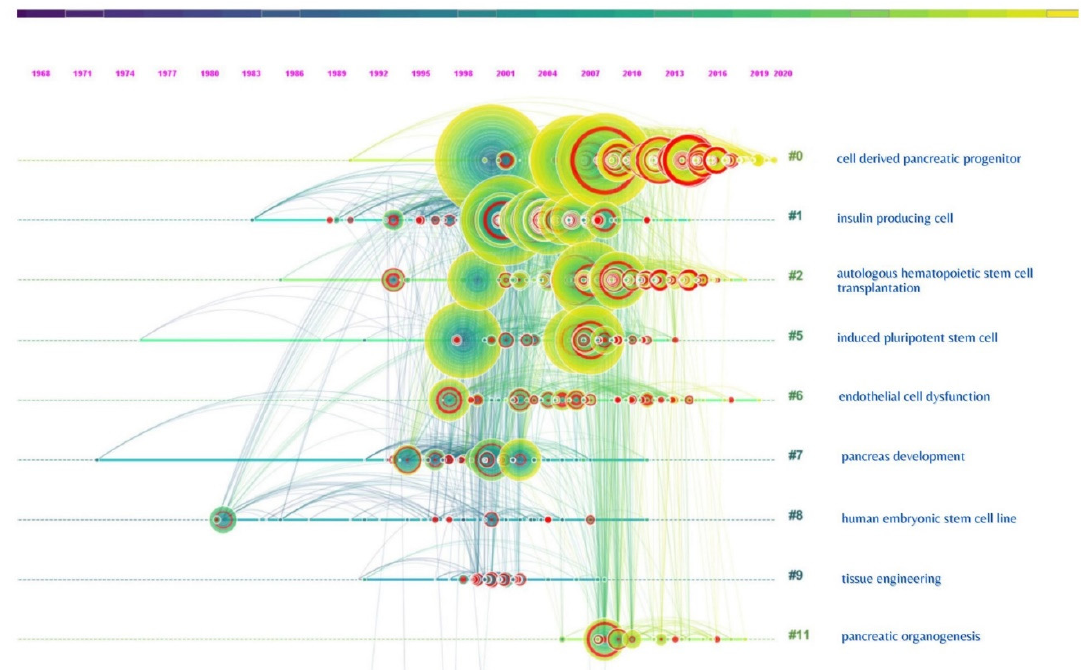
Figure 5. Timeline summary of the various clusters and their interactions on the use of stem cells for management of diabetes mellitus.